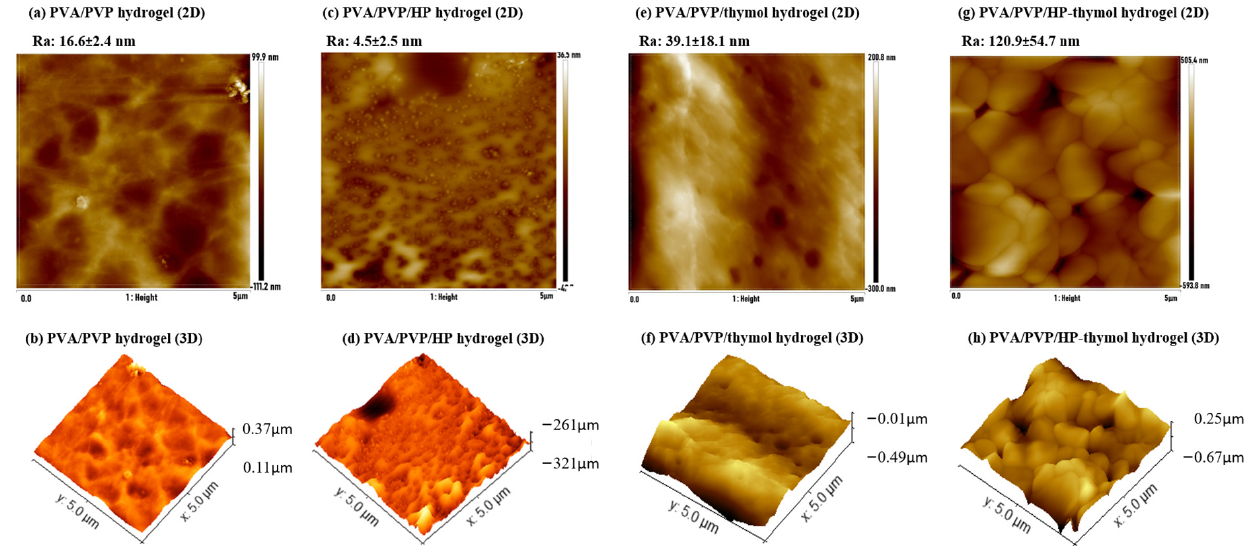
Figure 7. Hydrogel coating average roughness morphology in 2D and 3D views of PVA/PVP ( a , b ), PVA/PVP/HP ( c , d ), PVA/PVP/thymol ( e , f ) and PVA/PVP/HP-thymol ( g , h ).